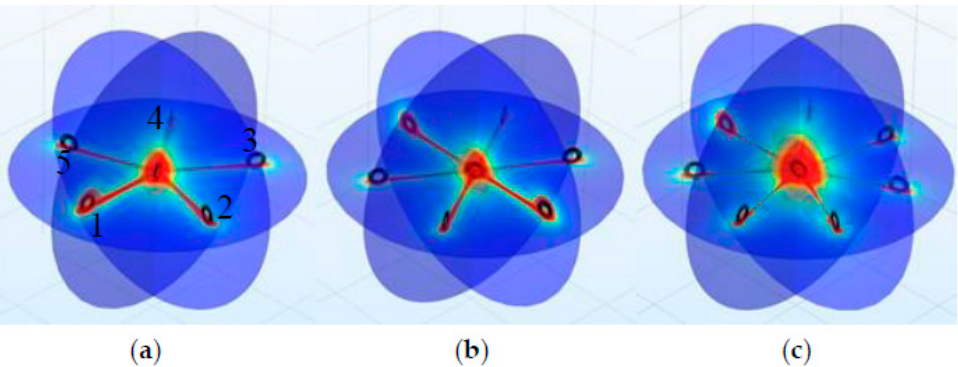
Figure 8. Electromagnetic field distribution of emanant systems with ( a ) five loads, ( b ) six loads and ( c ) seven loads.